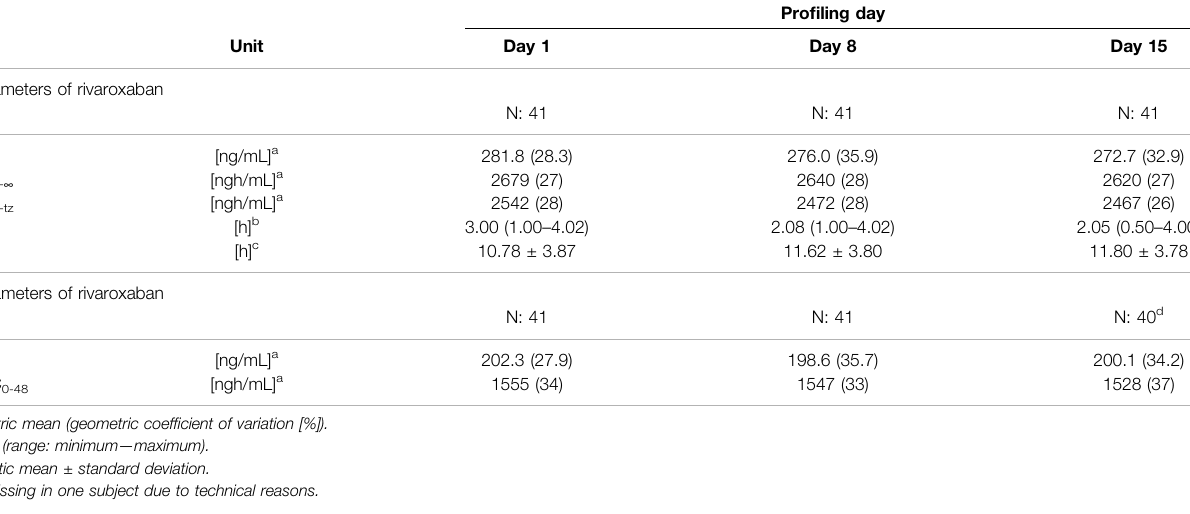
TABLE 1 | PK parameters of rivaroxaban (time courses of the plasma concentrations) and PD parameters (anti-FXa activity measured by chromogenic assay).